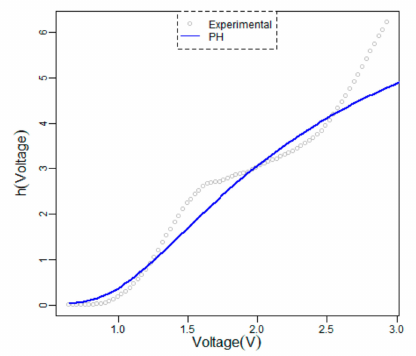
Figure 1. Statistical PH fit of the hazard rate of reset voltages collected from Ni/HfO 2 /Si RRAM